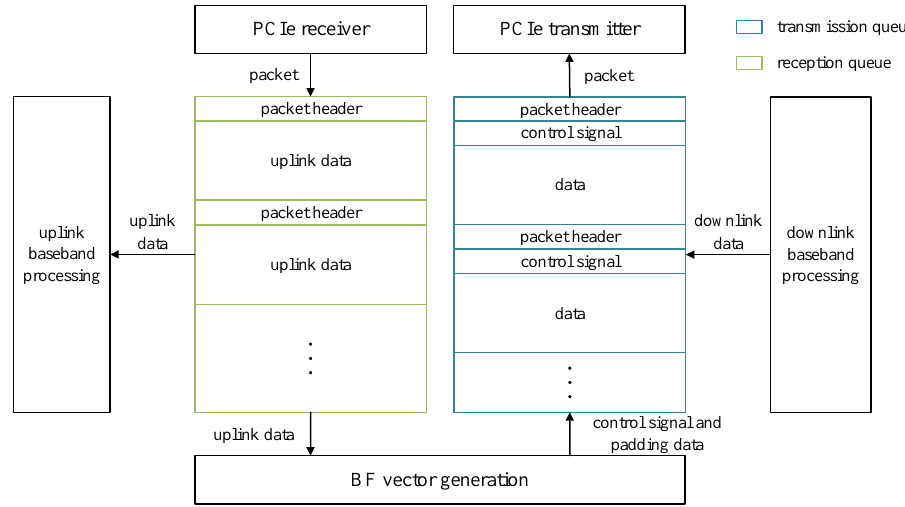
Figure 7. Data storage format and relationship between different